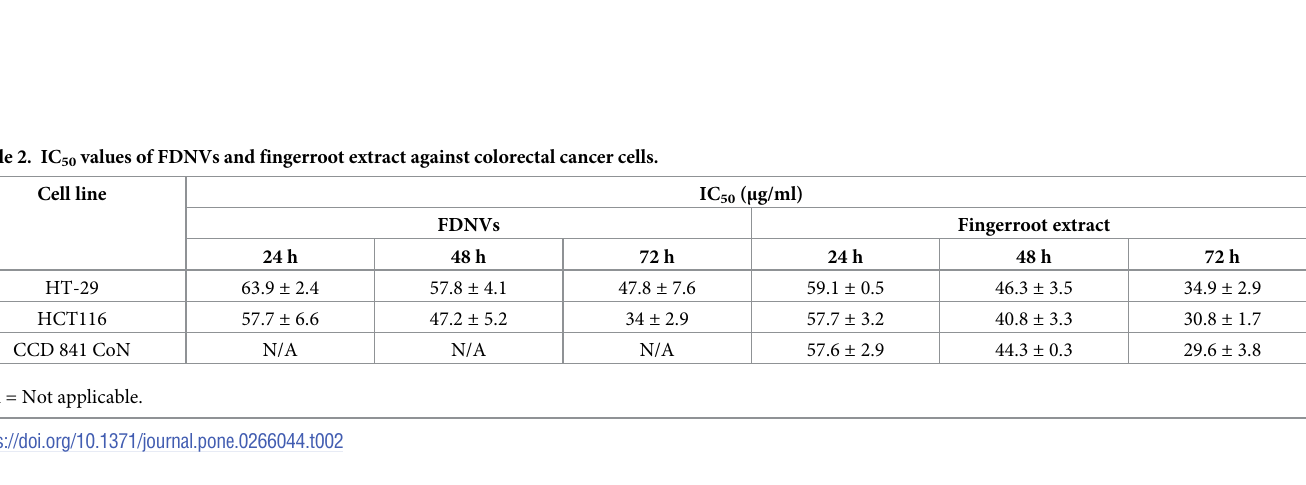
Fig 2. Cytotoxic effects of FDNVs and fingerroot extract on colorectal cancer and normal colon epithelial cell lines. Cell viabilities of (A) HT-29, (B) HCT116, and (C) CCD 841 CoN cells were determined using MTT assay after treatment with FDNVs and fingerroot extract for 24, 48, and 72 h. Data are represented as means ± SD of three independent experiments in triplicate. � P < 0.05, �� P < 0.01, ��� P < 0.001 (one-way ANOVA).